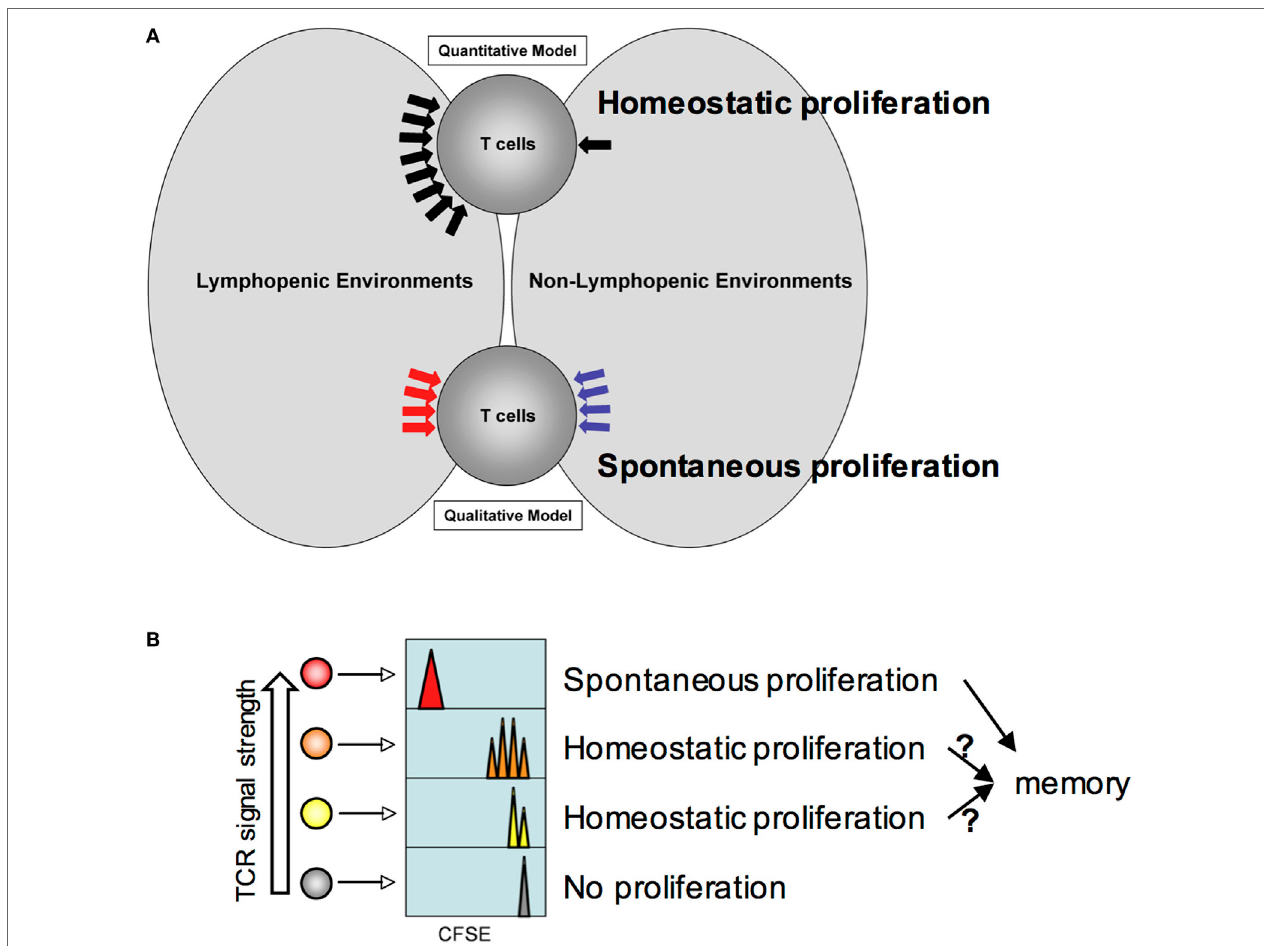
FiGURe 1 | Model for homeostatic and spontaneous proliferation. (A) Quantitative and qualitative signaling model. The model depicts potential signaling mechanisms during homeostatic and spontaneous proliferation. Homeostatic proliferation is triggered by excessive soluble resources available under lymphopenic environments. By contrast, spontaneous proliferation is triggered by different types of signaling mechanism only available under lymphopenic conditions. (B) Relative T cell receptors signal strength against endogenous peptide:MHC complexes determines which T cells undergo homeostatic and spontaneous proliferation. The higher the strength is, the more likely the T cells would undergo spontaneous proliferation. If the strength is below threshold, cytokine availability controls homeostatic proliferation. T cells would remain